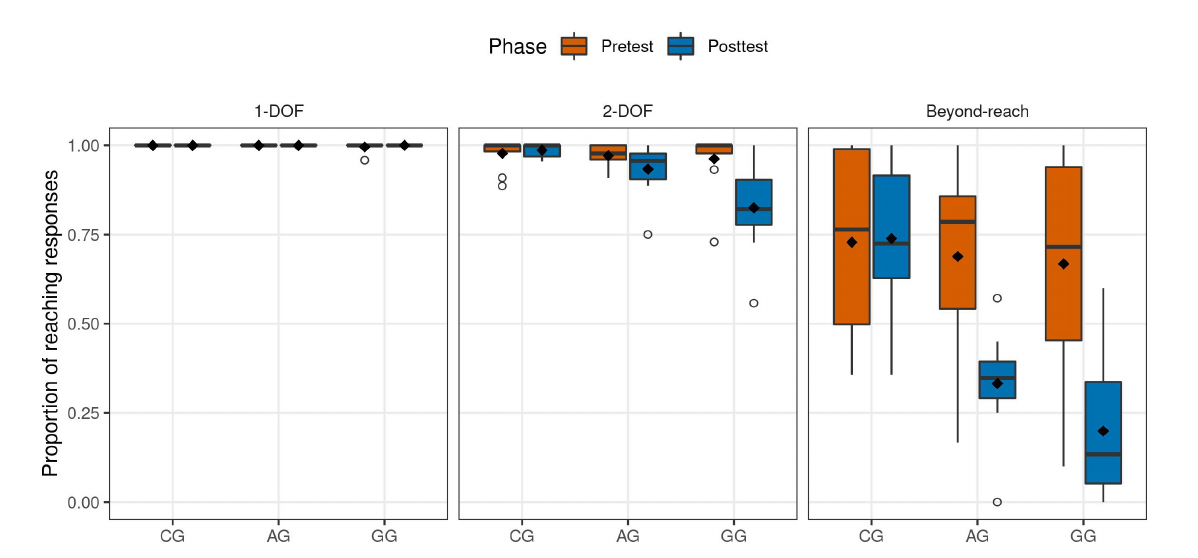
FIGURE2 Boxplot with proportion of reaching responses according to 1-DOF, 2-DOF, and Beyond-reach regions for each group and phase. Dots represent outliers and diamonds the